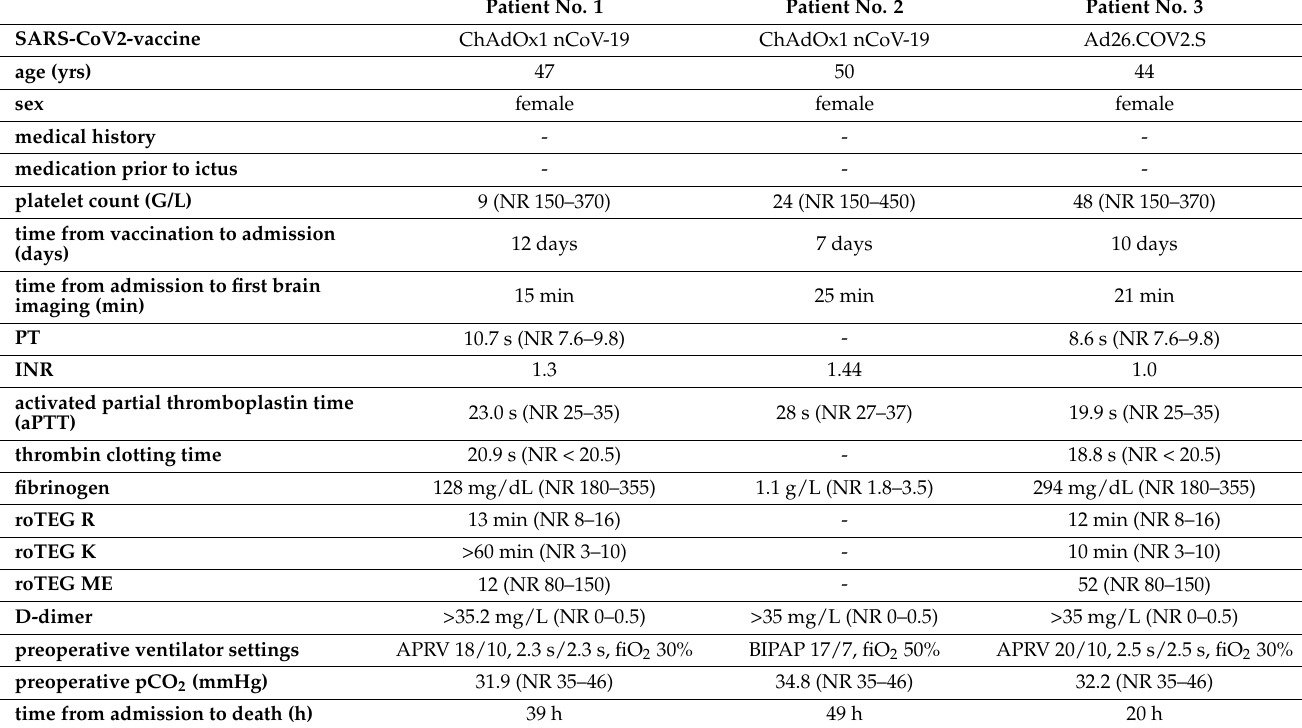
Table 1. Laboratory characteristics on admission. no. = number; NR = normal value range of the respective laboratory; yrs = years; PT = prothrombin time; INR = international normalized ratio; s = seconds; roTEG = rotational thromboelastogra- phy; R = reactive time; min = minutes; K = kinetic time; min = minutes; ME = maximum elasticity; h = hours; APRV = airway pressure release ventilation; fiO 2 = fraction of inspired oxygen; pCO 2 = partial pressure of carbon dioxide. Patient No. 1 Patient No.